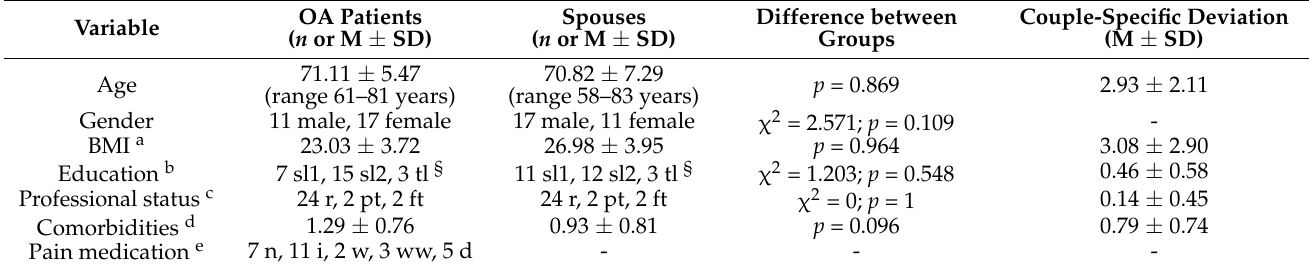
Table 1. Demographic characteristics of the OA patients and their